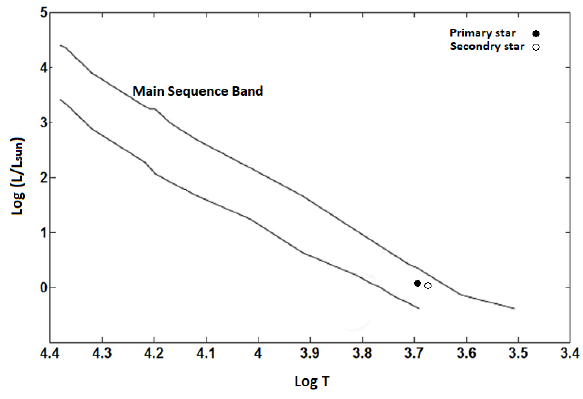
Figure 8. Position of both components of V1848 Ori on the H-R dia- gram, in which the theoretical ZAMS and TAMS curves are